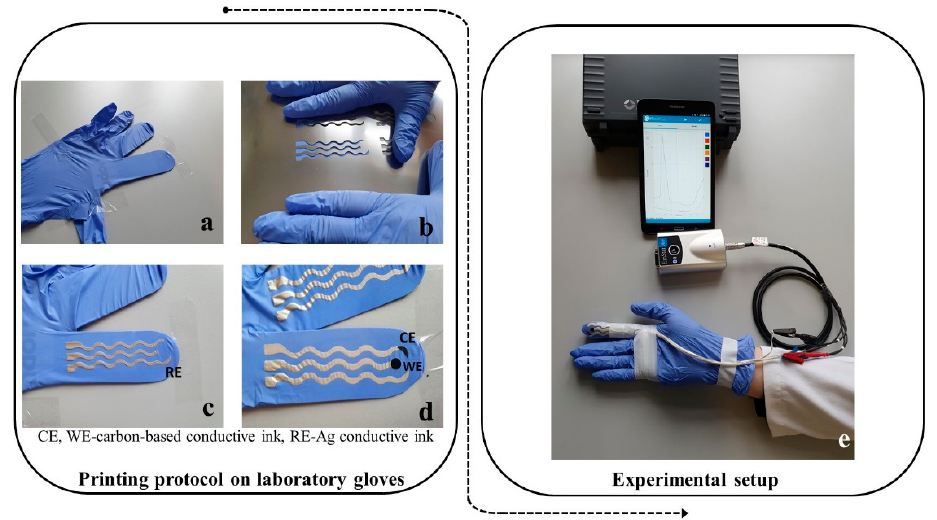
Figure 5. Images recorded during the printing protocol on laboratory gloves: ( a ) glove ready for printing; ( b ) stainless steel stencil with cut ‐ outs for printing the contacts and the electrochemical cell; ( c ) contacts and RE printed on one glove finger; ( d ) electrochemical cell and contacts printed on a glove finger; ( e ) images with the printed glove wired for connection to the portable potentiostat and smart tablet that ensures the operation of the system via Bluetooth transmission and specific software.